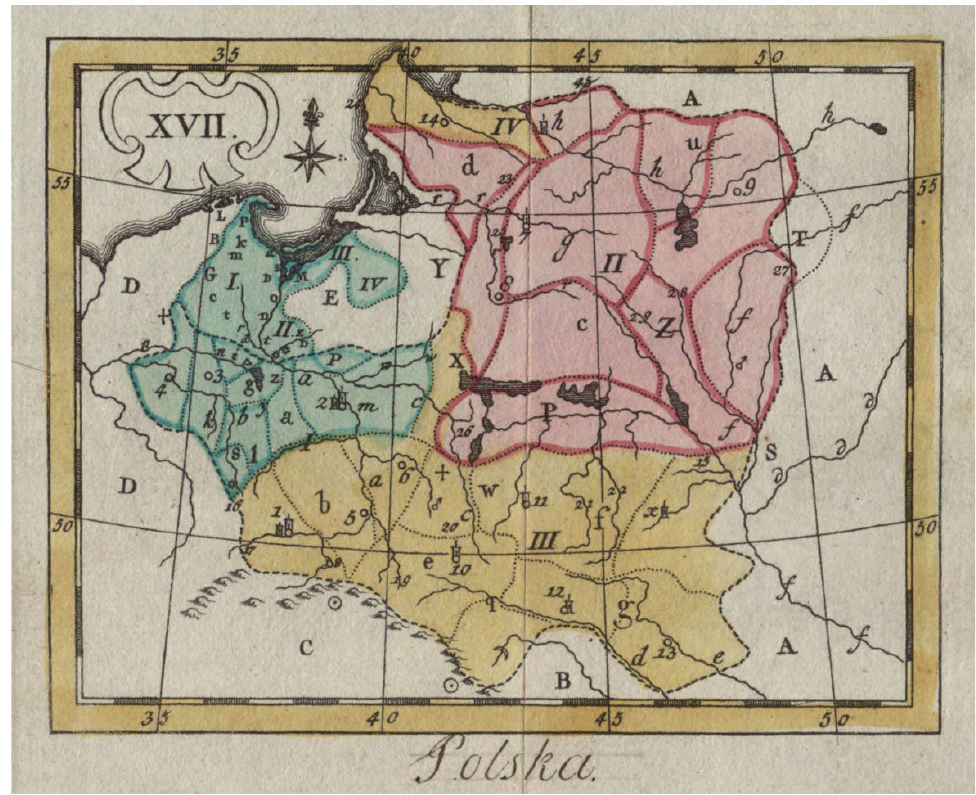
Fig. 1. The map of the Polish Kingdom from the atlas compiled by D. Szybiński (source: Plock Digital